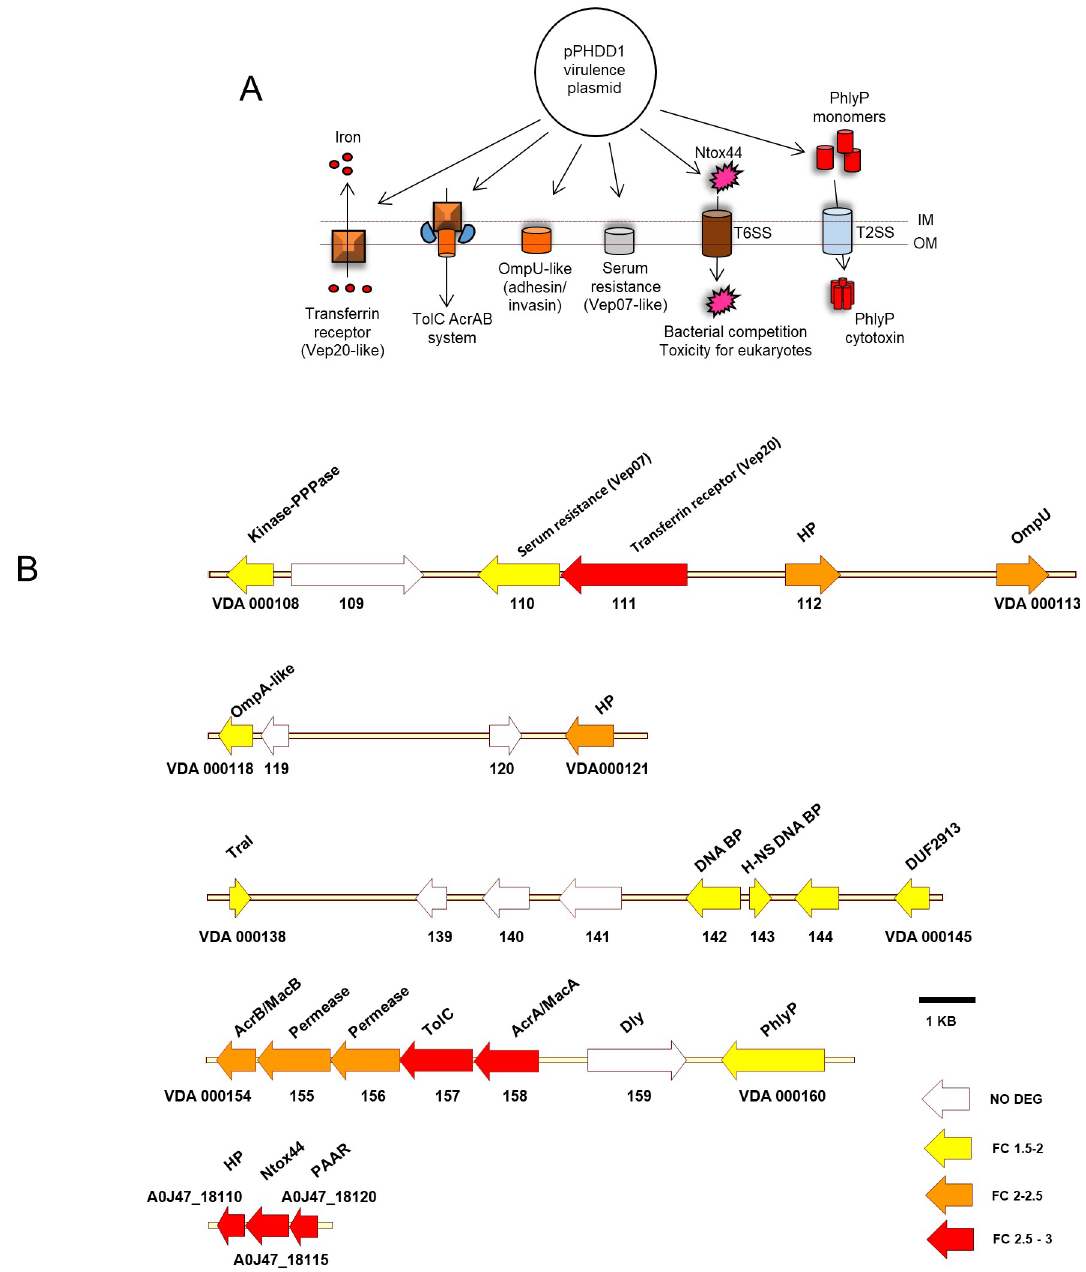
Fig 4. Virulence factors encoded within pPHDD1 plasmid are upregulated at 25˚C. (A) pPHDD1 encodes a series of membrane- associated proteins and toxins with demonstrated and potential roles for virulence in fish. (B) plasmid genes upregulated at 25˚C are mainly distributed along 5 plasmid regions. Numbers denote the VDA gene codes of the type strain CIP102761 (GenBank Acc. No. NZ_ADBS00000000.1). Genes with A0J47 labels correspond to genes unique to RM-71. Colour codes of genes (represented as arrows) denote each of the three ranges of FC values, whereas white arrows denote genes that are not differentially expressed (NO DEG).